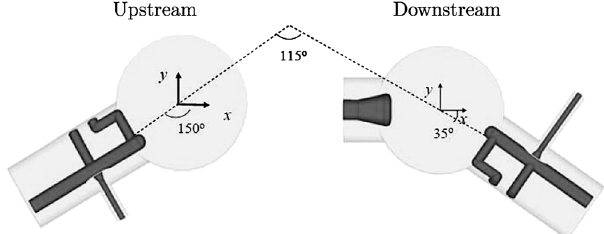
FIG. 4. Normalized amplitude V of the beam-excited TE 111 - 6 dipole mode for different beam trajectories. The dots are results of eigenmode calculations, and the dashed lines indicate a linear fit. In the left graph, paraxial trajectories with different offsets x are evaluated; the right graph shows the amplitude as calculated for different trajectory tilt angles x 0 through the longitudinal center of the